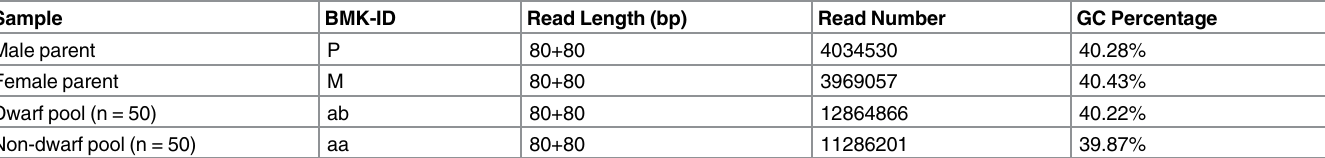
Table 3. Sequencing data of each sample.